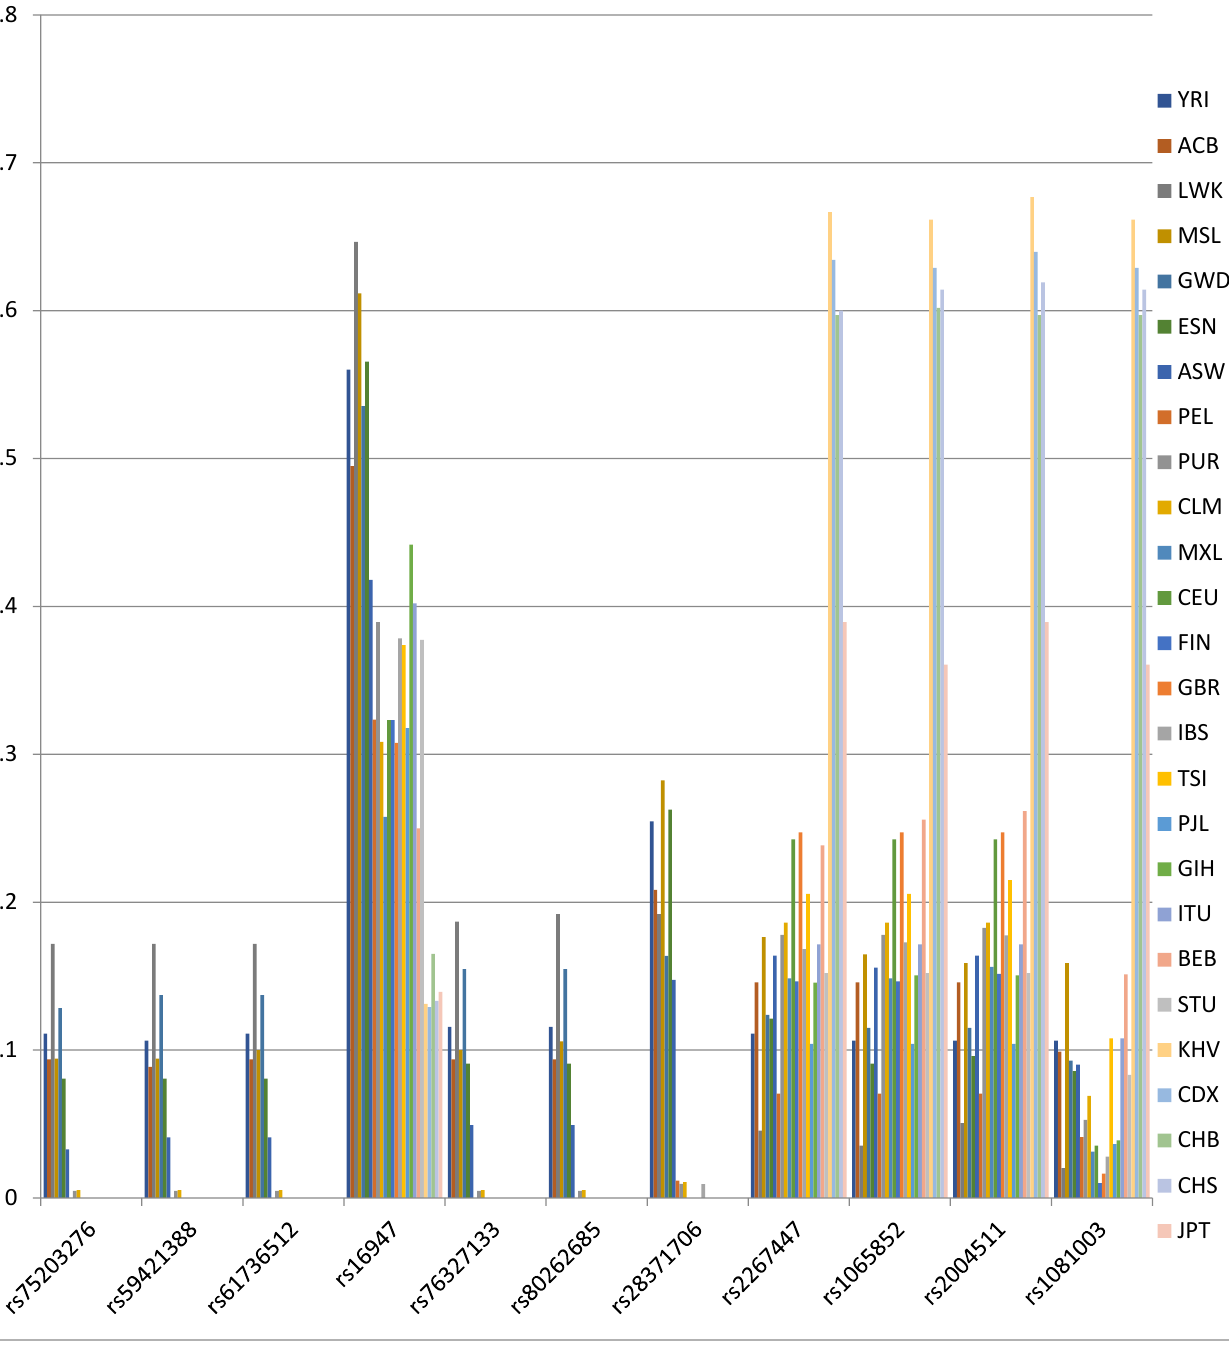
Figure 1. Distribution of minor alleles frequencies in 11 SNPs of the CYP2D6 gene in 26 world populations.